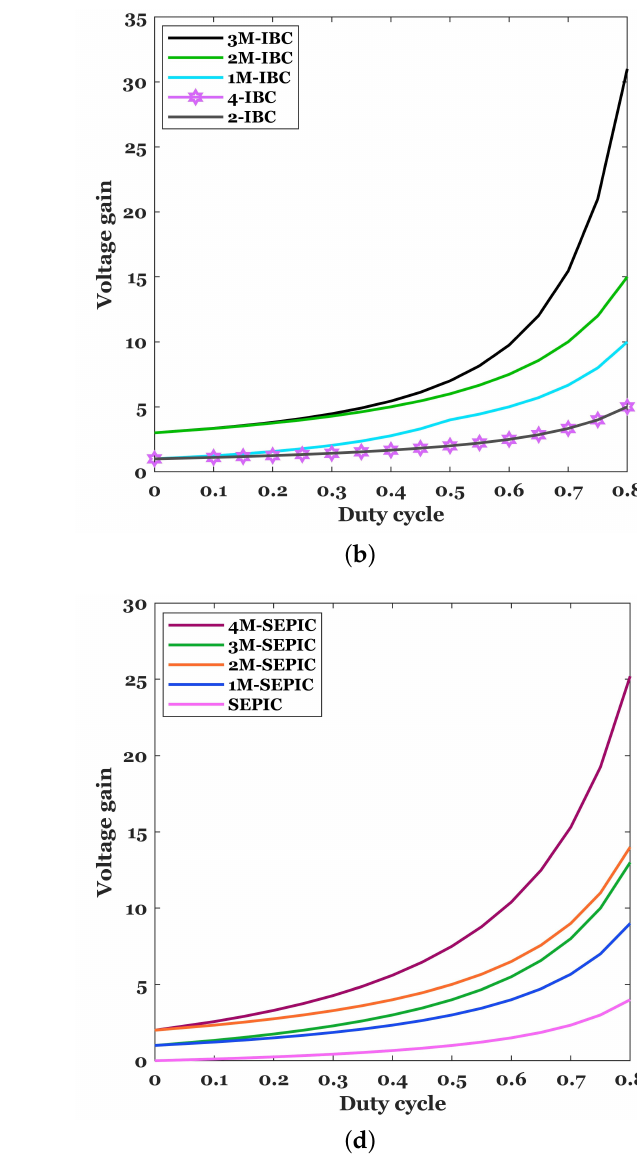
Figure 27. Voltage Gain ratio of Converters ( a ) Group 1 (DBC, TBC, 1st M-TBC, DuBC, TLBC, 1st M-TLBC, and 2nd M-TLBC) ( b ) Group 2 (2-IBC, 4-IBC, 1st M-IBC, 2nd M-IBC, and 3rd